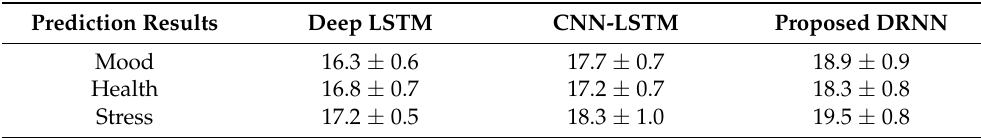
Figure 8. Comparative analysis between existing and proposed classification techniques for varying sessions.